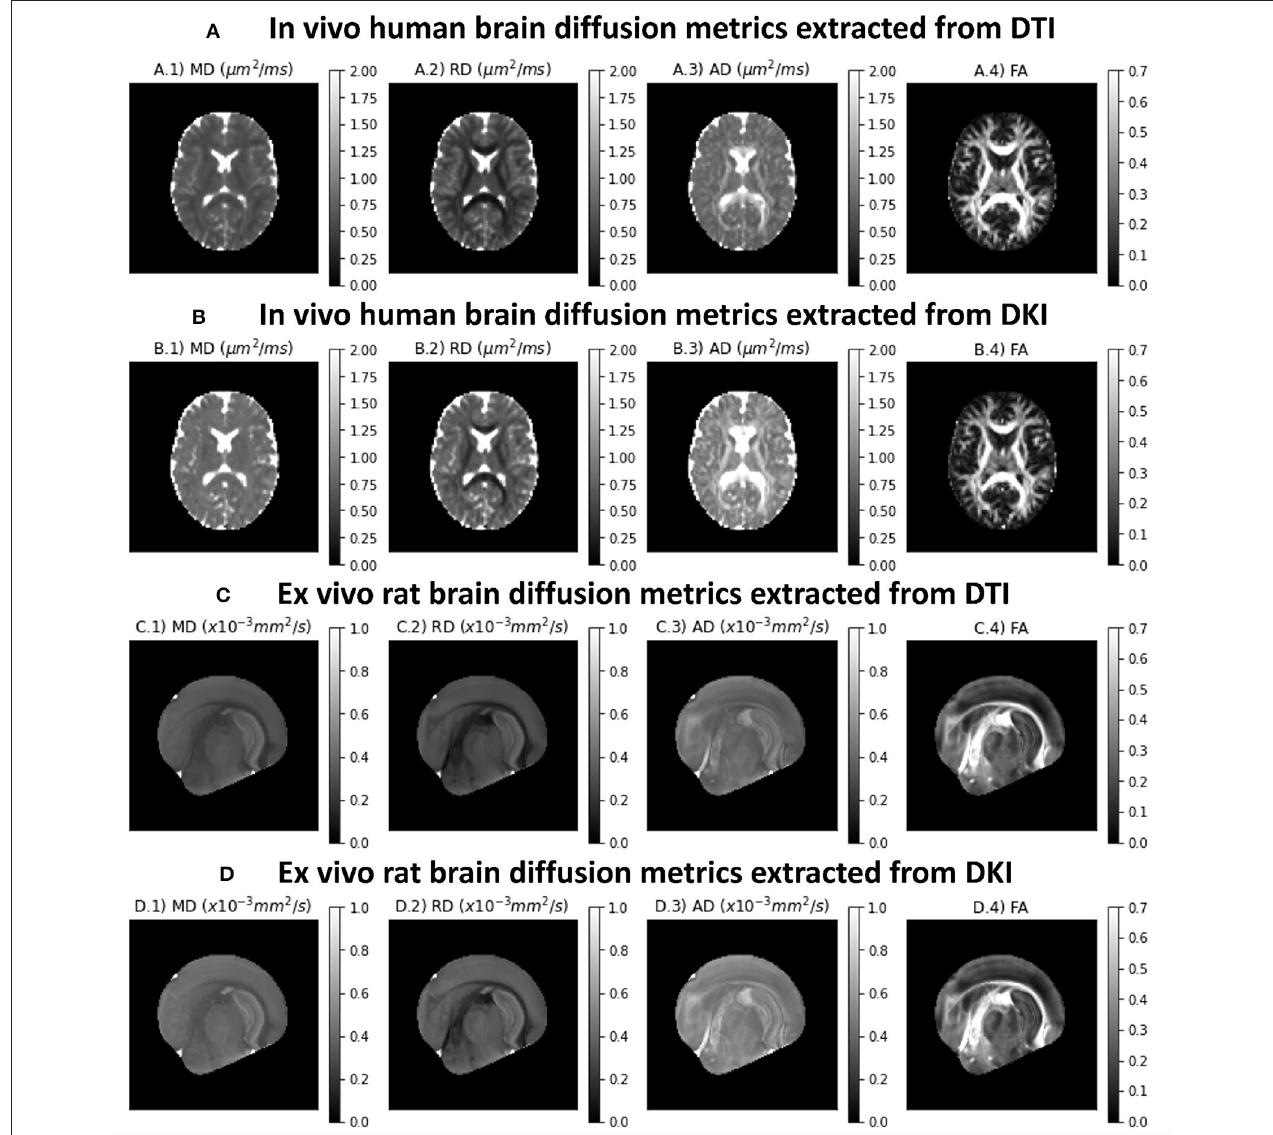
FIGURE 4 | Standard diffusion metrics for a representative axial slice of the the two CFIN datasets and extracted from both DTI and DKI models implemented in DIPY: (A) DTI diffusion metrics for the in vivo human brain dataset; (B) DKI diffusion metrics for the in vivo human brain dataset; (C) DTI diffusion metrics for the ex vivo rat brain dataset; (D) DKI diffusion metrics for the ex vivo rat brain dataset;. Left to right panels show the maps of mean diffusivity (A.1,B.1,C.1,D.1), radial diffusivity (A.2,B.2,C.2 D.2), axial diffusivity (A.3,B.3,C.3,D.3), and Fractional Anisotropy